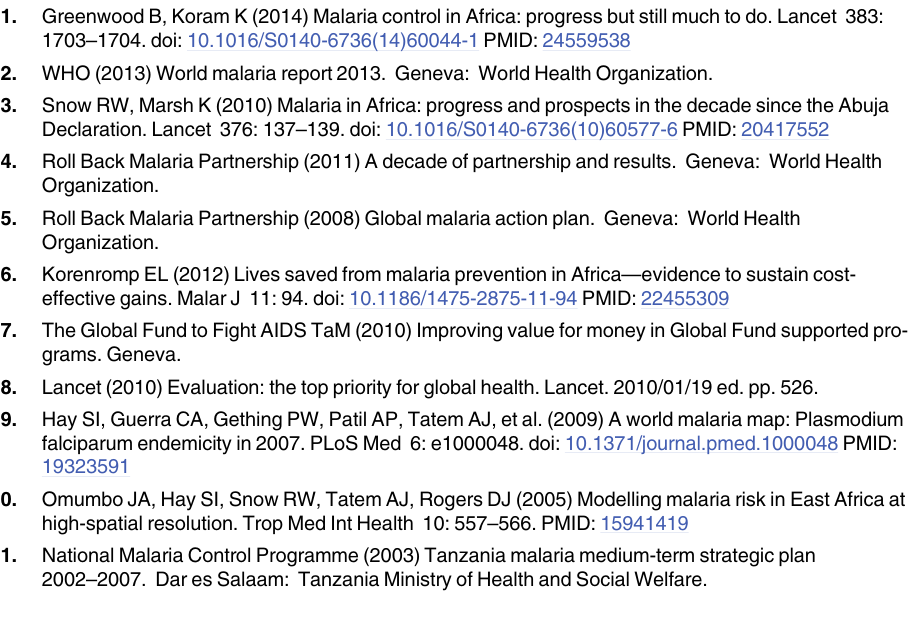
S2 Fig. Insecticide treated net (ITN) coverage (A), severe anemia (Hb < 8.0 g/dL) prevalence (B), and all-cause mortality among children under-five (C) stratified by background char- acteristics in Mainland Tanzania, 2004/5, 2007/8, and 2010. S3 Fig. Weighted anomaly of standardized precipitation (WASP) analysis for Tanzania comparing (A) baseline period (1995 – 99) and (B) malaria intervention scale-up years (2000 – 10). Footnote: red indicates drier, green indicates wetter (compared to baseline)